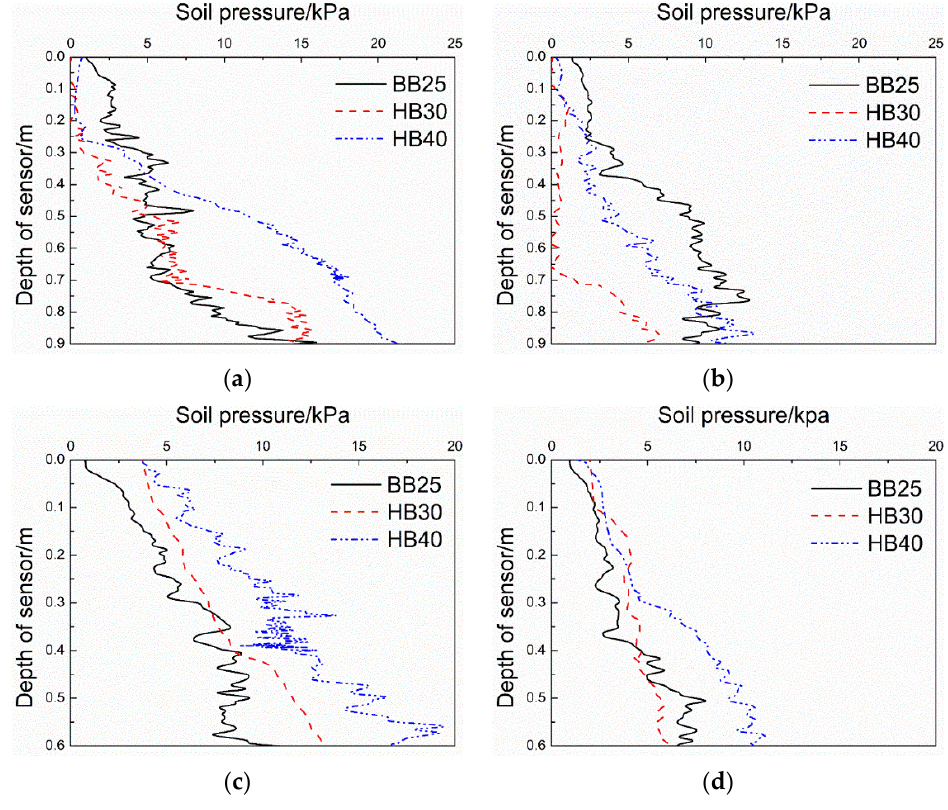
Figure 10. Lateral soil pressure: ( a ) J-10; ( b ) Y-10; ( c ) J-40; ( d ) Y-40.